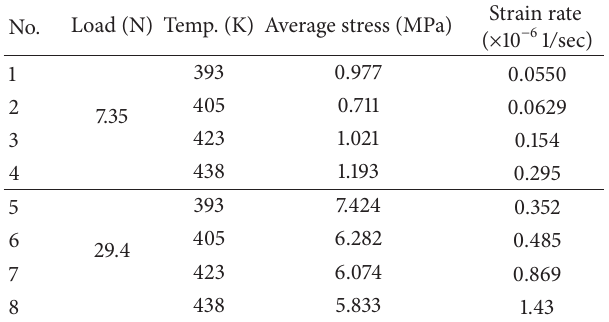
Table 3: Results of the shear creep specimen